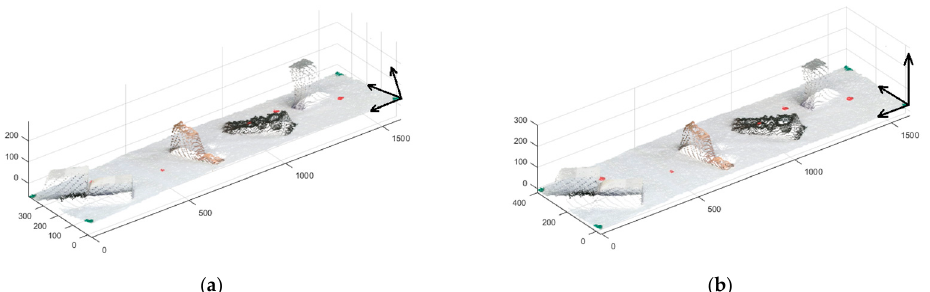
Figure 10. The black arrows represent the point clouds axis on the origin. ( a ) Point cloud on the Kinect coordinate frame; ( b ) point cloud on the robot coordinate frame.